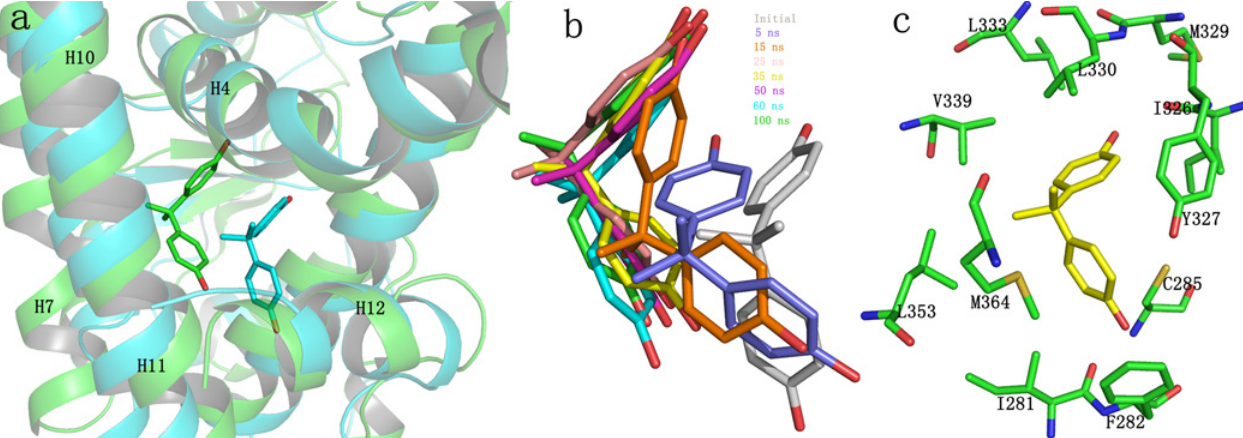
Fig 12. Direct interactions between BPA and hPPAR γ . a) Superimposition of the initial structure (cyan) to the 100ns structure (green) of hPPAR γ -BPA complex with BPA shown in sticks; b) Movement of BPA in the binding pocket at different times; c) Sticks representation of the interaction between BPA (yellow) and hPPAR γ